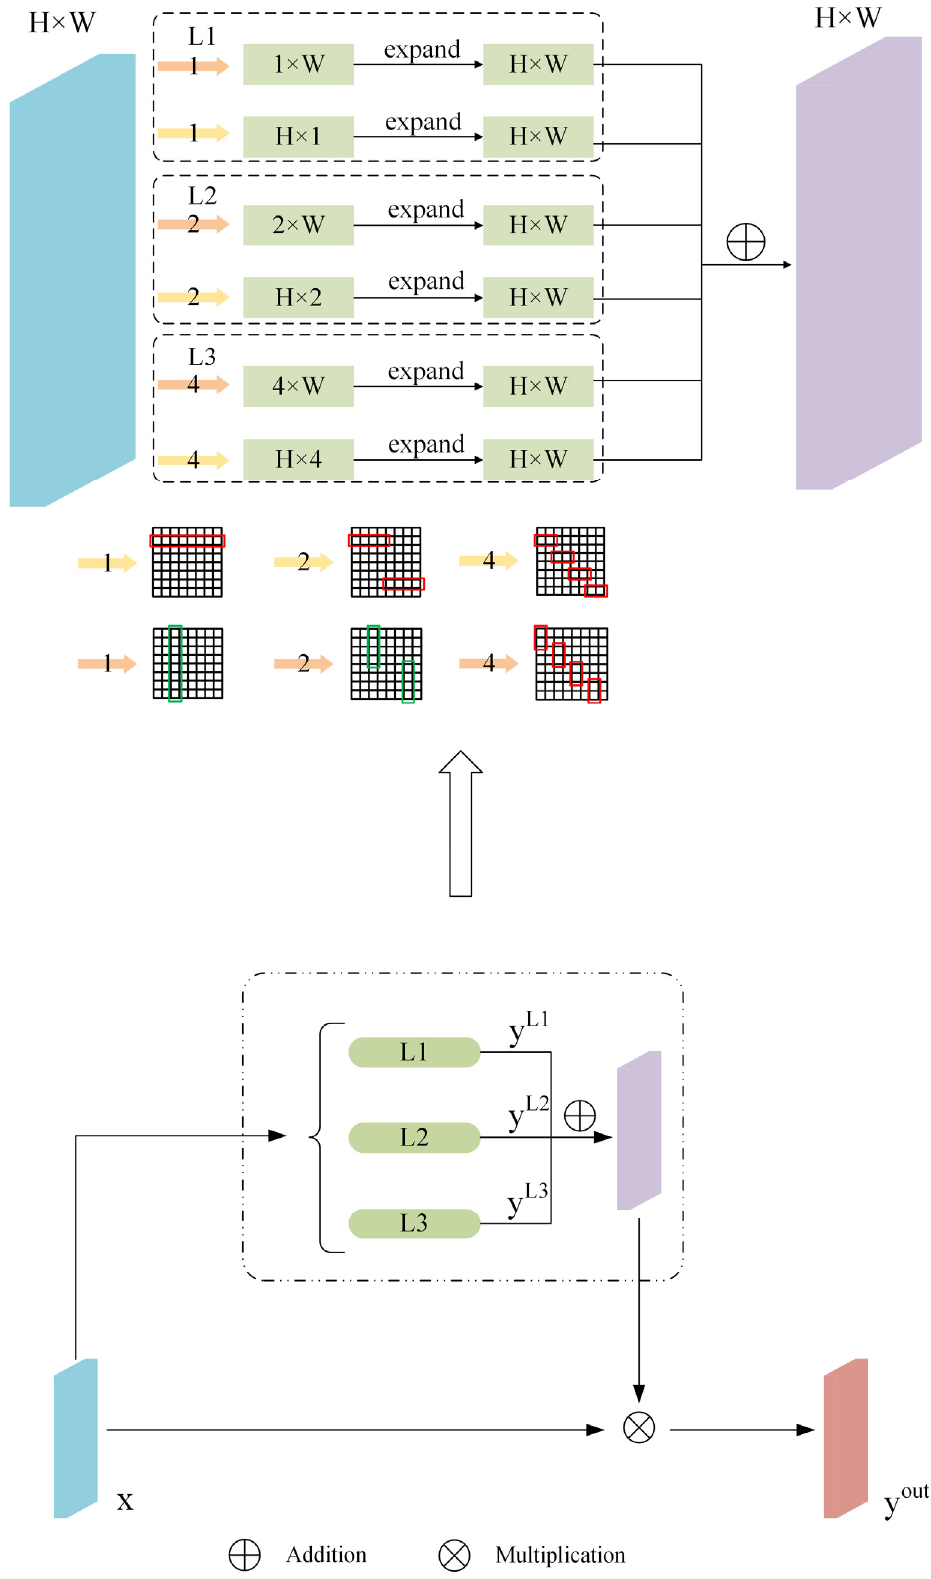
Figure 3. The structure of MSPM.